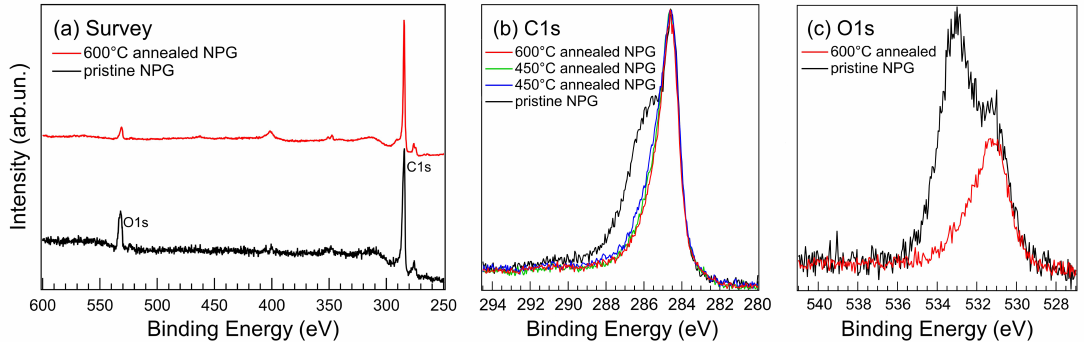
Figure 3. ( a ) XPS survey spectra of as-mounted pristine NPG and after annealing at 600 ◦ C temperature in UHV; ( b ) C 1s core level XPS spectra of NPG as pristine sample and as a function of annealing temperature and time, from the bottom 450 ◦ C for 5 h, 450 ◦ C for 8 h and 600 ◦ C for 30 min; ( c ) O 1s core level XPS spectra of NPG as pristine sample and after annealing at 600 ◦ C for 1